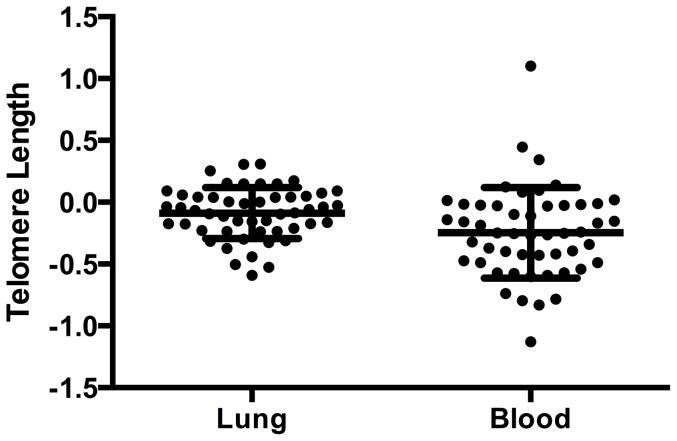
Mean log10 of telomere length in the blood and lung tissue.